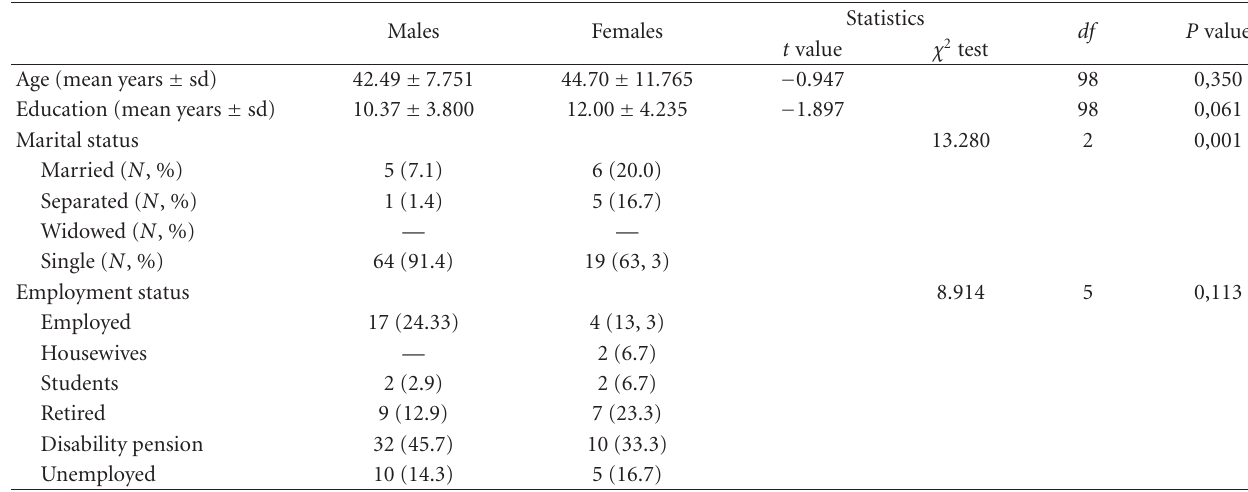
Table 2: Sociodemographic characteristics of the sample according to